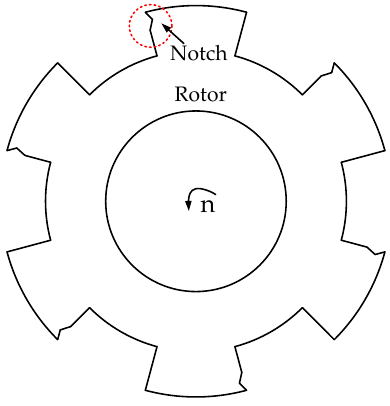
Figure 15. The notch of the rotor pole [55].